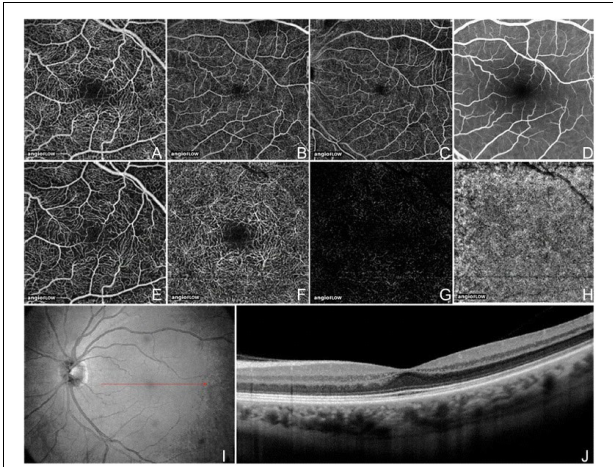
FIGURE 1 | Optical coherence tomography angiography (OCT-A) fields of view and segmentation layers (Angiovue). The normal left eye of a 56-year-old Caucasian man using the Angiovue optical coherence tomography angiography (OCTA) software of the RTVue XR Avanti (Optovue, Inc., Fremont, CA, United States). (A) Full-thickness (internal limiting membrane to Bruch’s membrane) 3 mm × 3 mm OCT angiogram. (B) Full-thickness 6 mm × 6 mm OCT angiogram. (C) Full-thickness 8 mm × 8 mm OCT angiogram. (D) Fluorescein angiography cropped to approximately 8 mm × 8 mm or 30 degrees demonstrates a less capillary detail than (A–C) . (E) 3 mm × 3 mm OCT angiogram of the “Superficial” inner retina. (F) 3 mm × 3 mm OCT angiogram of the “Deep” inner retina. (G) 3 mm × 3 mm OCT angiogram of the outer retina shows absence of vasculature. The white represents noise. (H) 3 mm × 3 mm OCT angiogram of the choriocapillaris is generally homogenous. There is black shadowing from retinal vessels. (I) Enface intensity OCT image. (J) Highly sampled OCT b-scan image. This figure was reprinted from de Carlo et al. (507) with